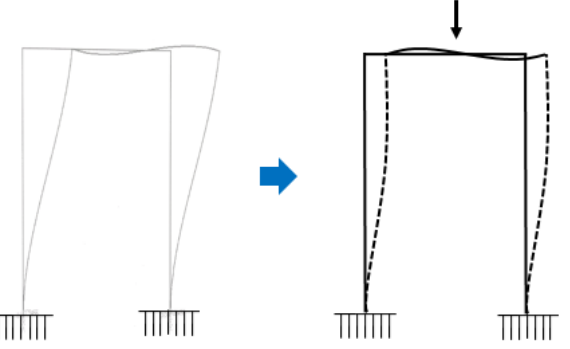
Figure 4. Idealization of approximate analytical approach for asymmetric mode.